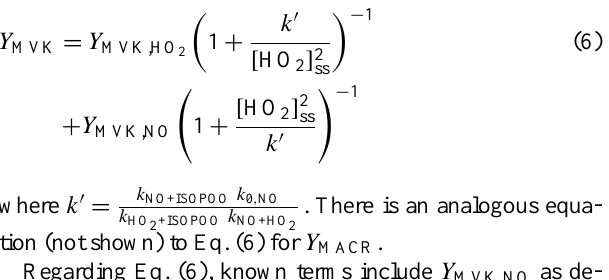
Fig. 4. Optimization of Y MVK,HO data of MVK and MACR according to Eq.